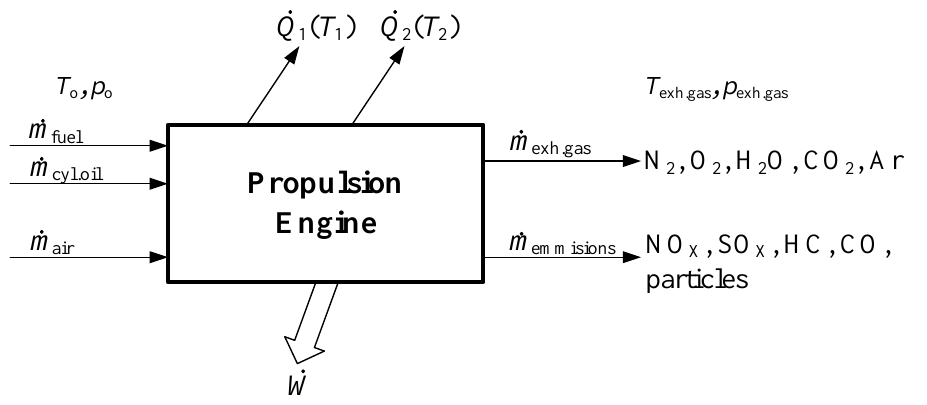
Figure 2. The propulsion engine model depicting main input and output